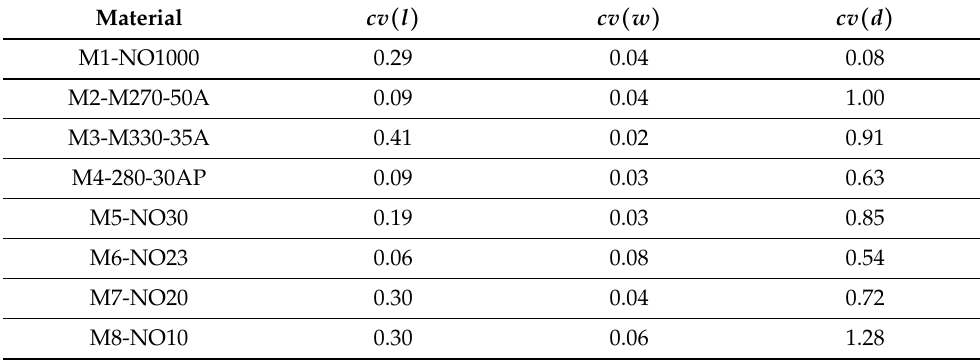
Table 2. Coefficient of variation cv for measurements of geometrical values in %.